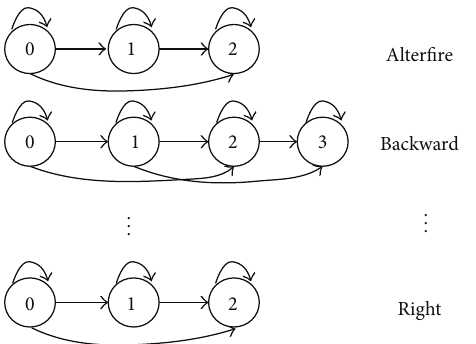
Figure 5: Hidden Markov Models (HMMs) learned for arm gesture recognition.